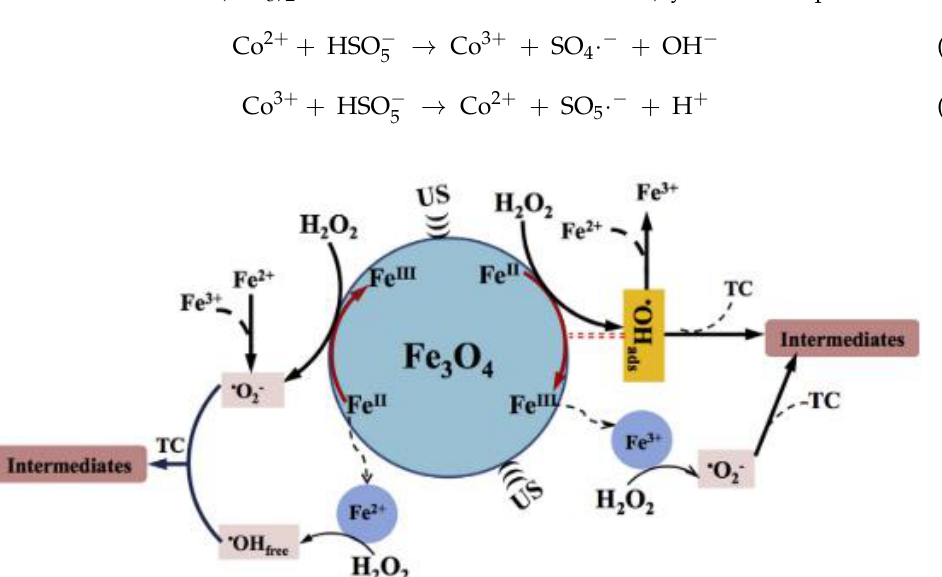
Figure 4. Proposed mechanism for the US/H 2 O 2 /Fe 3 O 4 system. Reprinted with permission from [43].